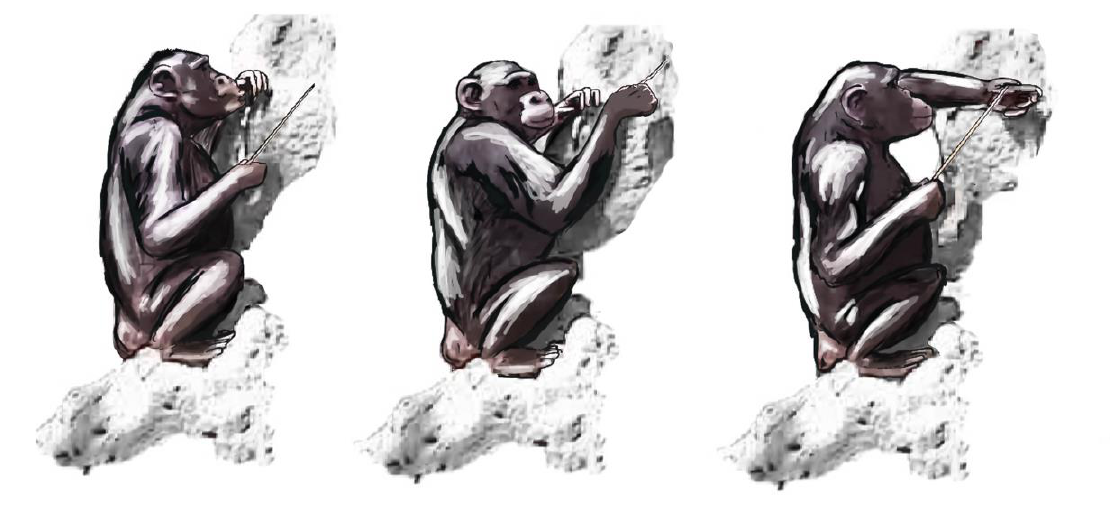
Drawing courtesy of Antonio J.